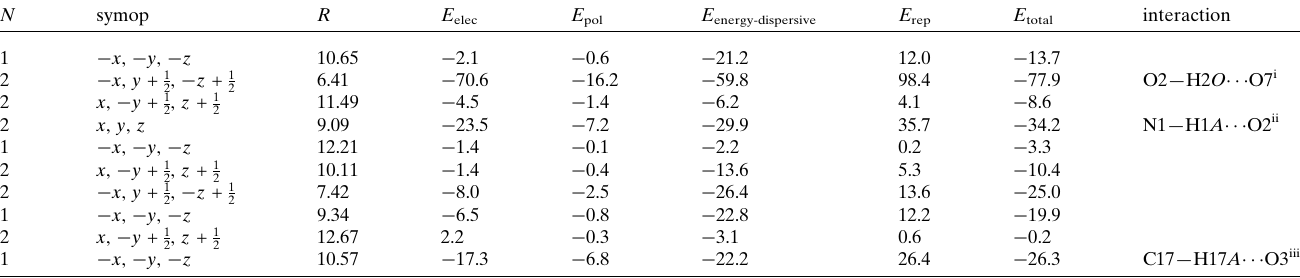
Table 4 Interaction energies for BF2 (kJ mol (cid:5) 1 ). R is the distance between molecular centroids (mean atomic position) in A˚ and N is the number of molecules at that distance. Total energies are the sum of the four energy components, scaled according to the appropriate scale factor ( a ) . N symop R E